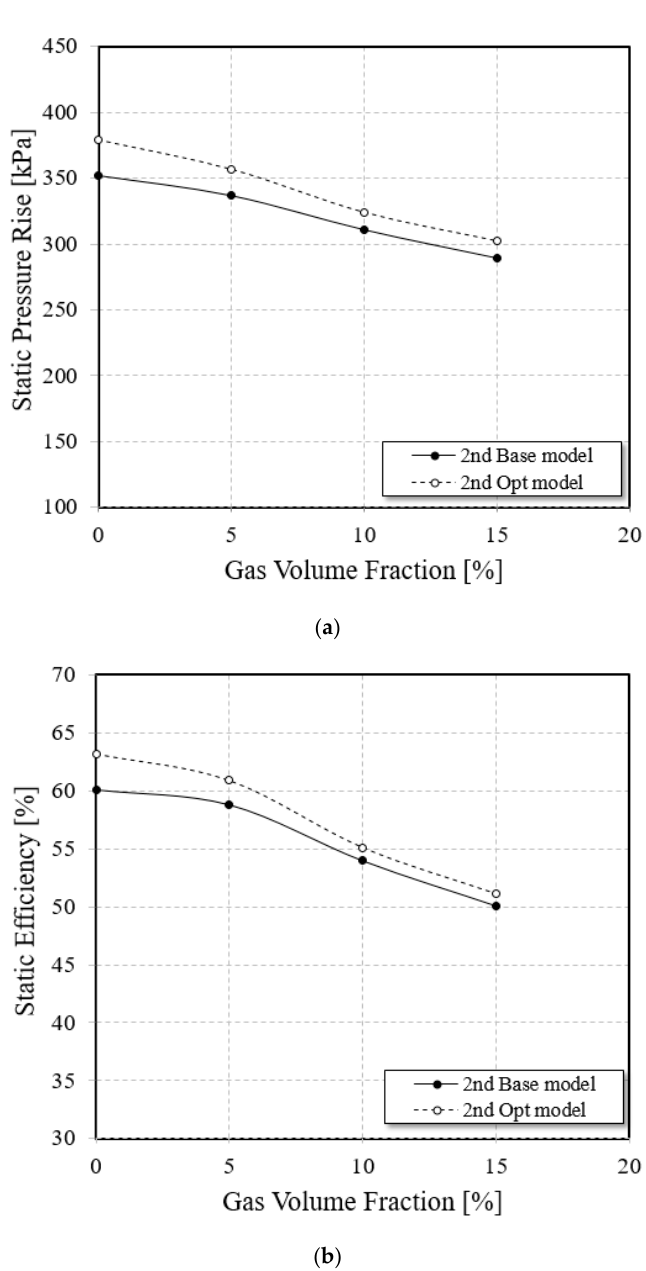
Figure 10. Performance comparison of the base model and optimum model. ( a ) Gas volume fraction vs. static pressure rise; ( b ) Gas volume fraction vs. static efficiency.